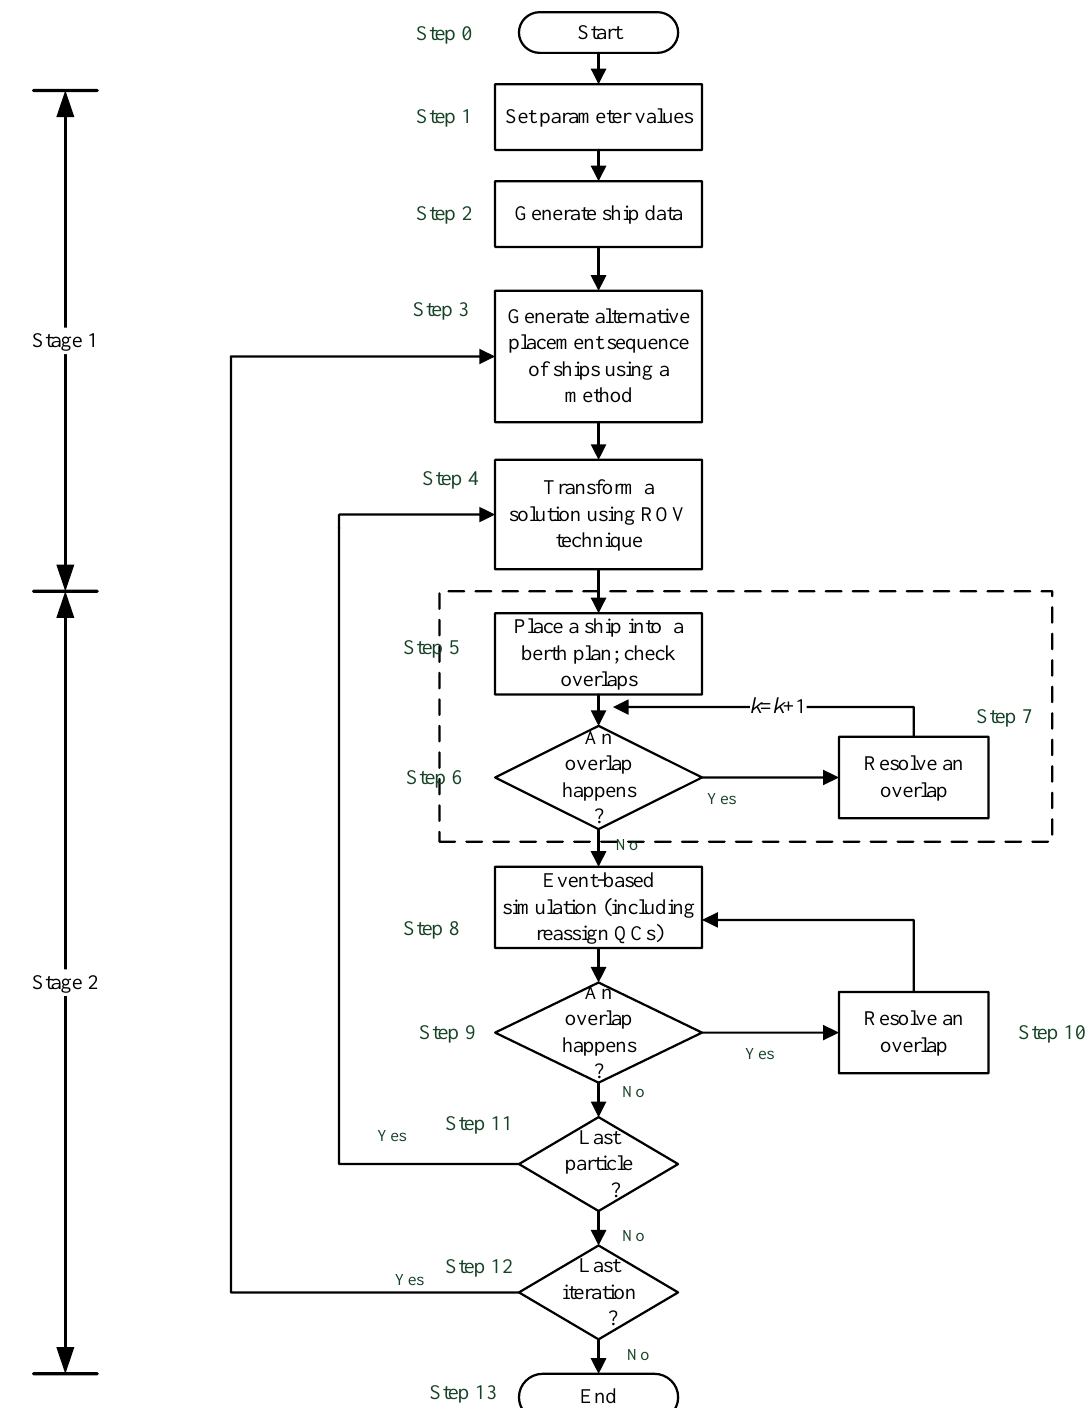
Figure 6. The algorithm of the two-stage procedure.